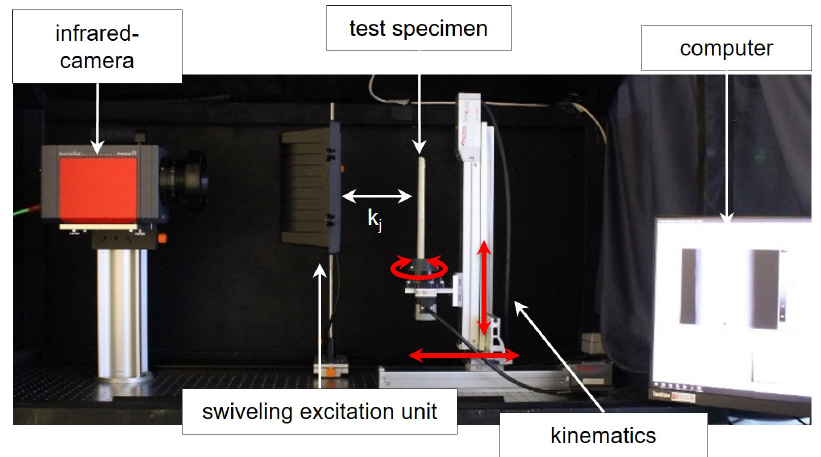
Figure 3. Photograph of the developed test set-up with the distance k = 114mm between the excitation unit and the test specimen.